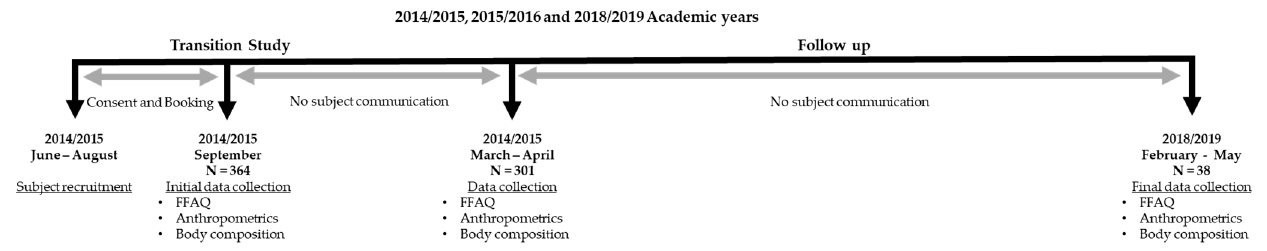
Figure 1. Study Figure 1. Study design.